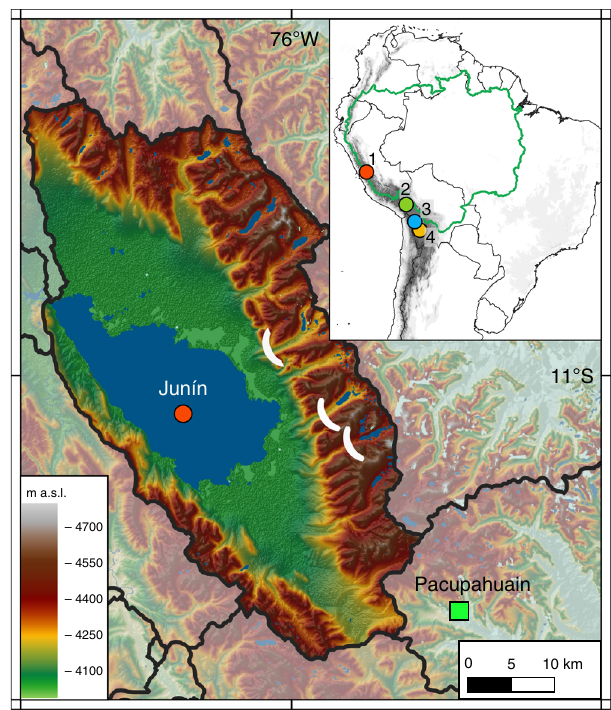
Fig. 1 Location of the Lake Junín (4100 masl) drainage basin and Pacupahuain cave in central Peru. White ellipses in valleys east of Lake Junín indicate the mapped down valley extent of glaciers during the local Last Glacial Maximum 24 . Inset map: green line indicates the Amazon drainage basin, and circles indicate Andean records discussed in the text: